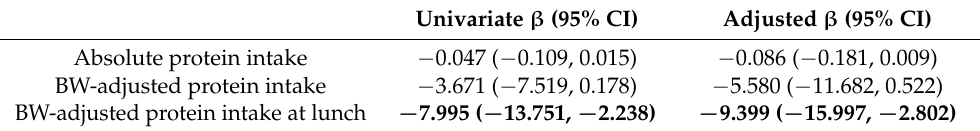
Table 3. Linear regression for protein intake and systolic blood pressure.